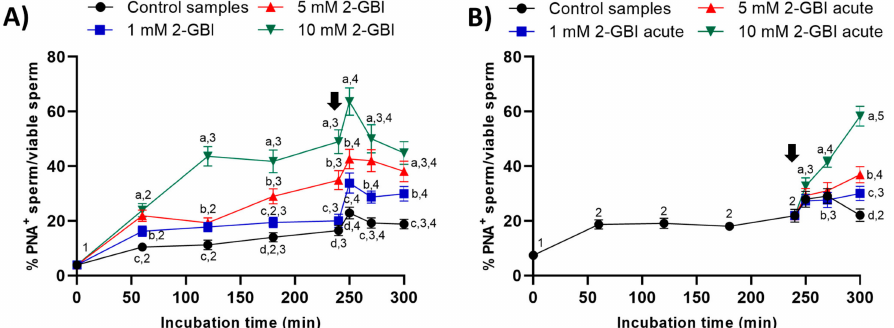
Figure 7. Percentages of viable sperm with exocytosed acrosome (PNA − ) in relation to total viable sperm (EthD-1 − ) throughout the incubation of sperm samples in capacitating medium (control samples) and capacitating medium plus 1 mM, 5 mM or 10 mM 2-GBI. The blocker was added to capacitating medium either at 0 min in experiment 1 ( A ) or after 240 min of incubation in experiment 2 ( B , acute). Di ff erent superscript letters (a–d) indicate significant di ff erences ( p < 0.05) between samples within the same time point, and di ff erent superscript numbers (1–5) indicate significant di ff erences ( p < 0.05) between time points within a given treatment. Results are expressed as mean ± SEM (n = 10). The arrow indicates the time at which 10 µ g / mL of progesterone was added to all samples (i.e., 240 min of